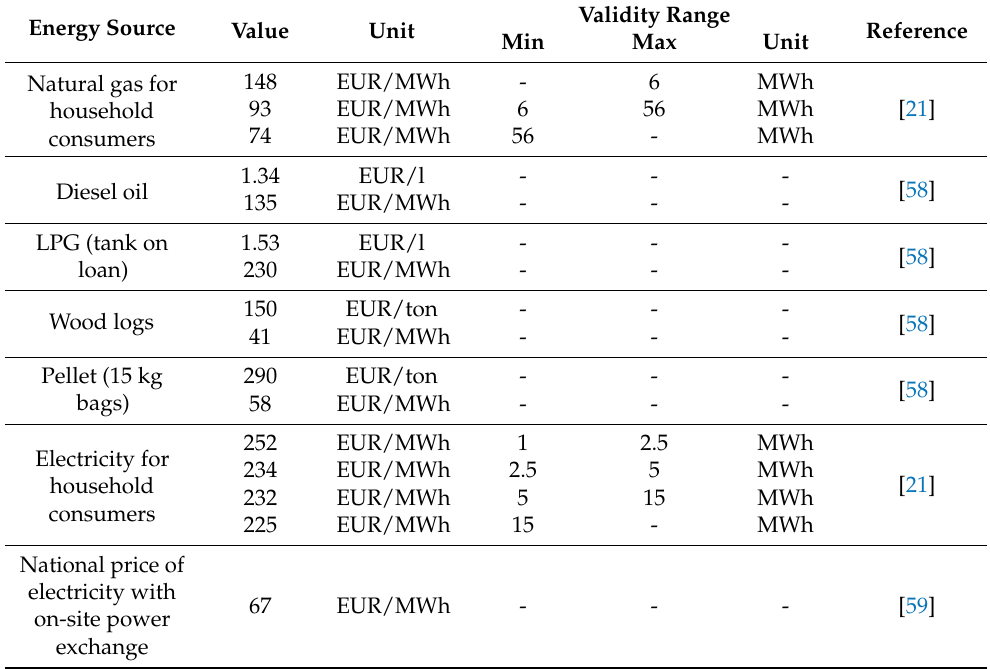
Table 4. Unit prices of energy